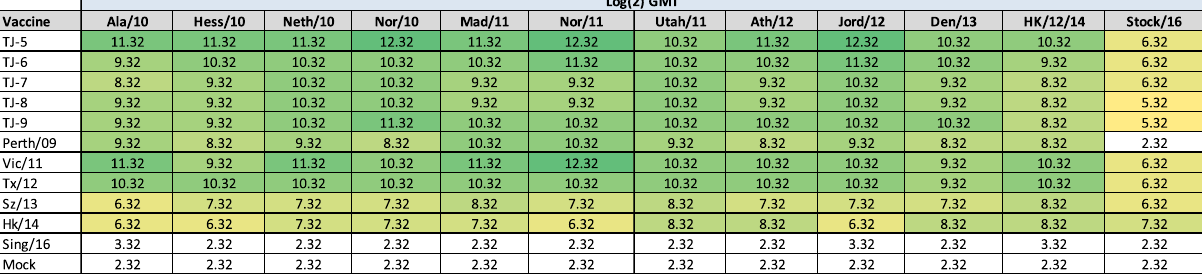
Table 4. 2010–2016 Co-circulating H3N2 influenza virus HAI panel. HAI assays were performed against a panel of co-circulating influenza strains isolated from 2010–2016 with day 70 serum from vaccinated mice. The average log 2 geometric mean HAI serum antibody titers (GMTs) were determined for each group of mice (n = 5) and are presented in a heat map form. Colored cells represent groups that achieved a GMT ≥ 5.32, which